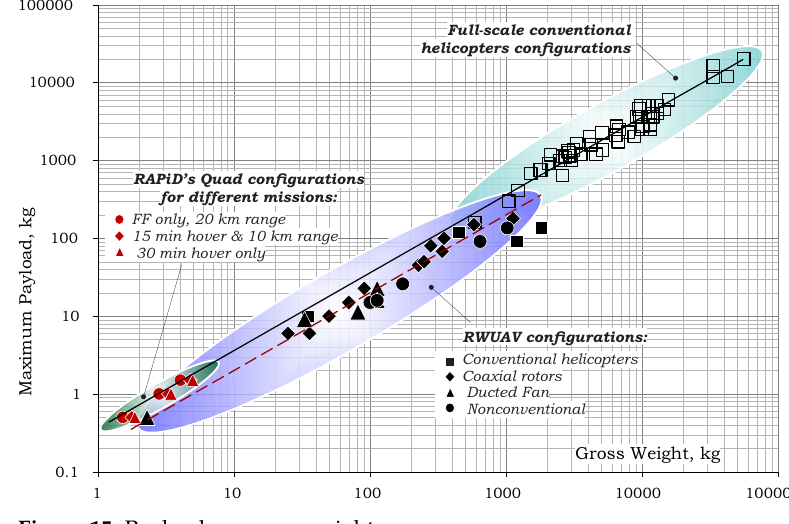
Figure 15. Payload vs. gross-weight.